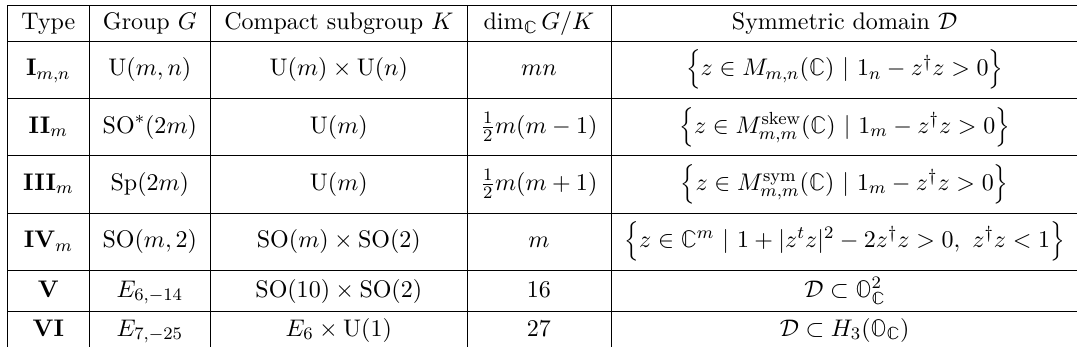
Table 3 . Irreducible hermitian symmetric manifolds of noncompact type, their complex dimension, and the bounded symmetric domain. With M m,n ( C ) we denote the set of m -by- n complex matrices, and M skew(sym) m,m ( C ) refers to the subset of m -by- m antisymmetric(symmetric) complex matrices; O C refers to the complexification of octonions (also called the complex Cayley algebra), and H 3 ( O C ) is the Hermitian 3 × 3 matrices with entries in O C . The symmetric domains of the last two exceptional types described in ref.